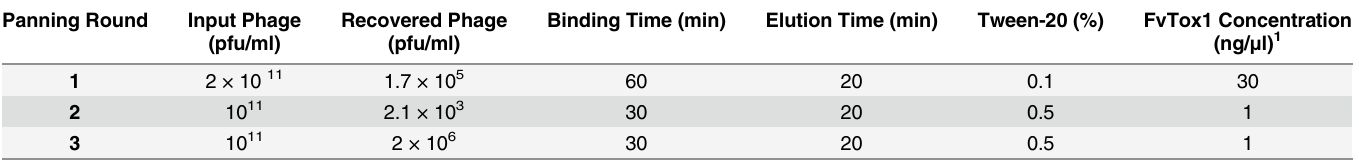
Table 1. Bio-panning conditions for screening three M13 phage display libraries. Panning Round